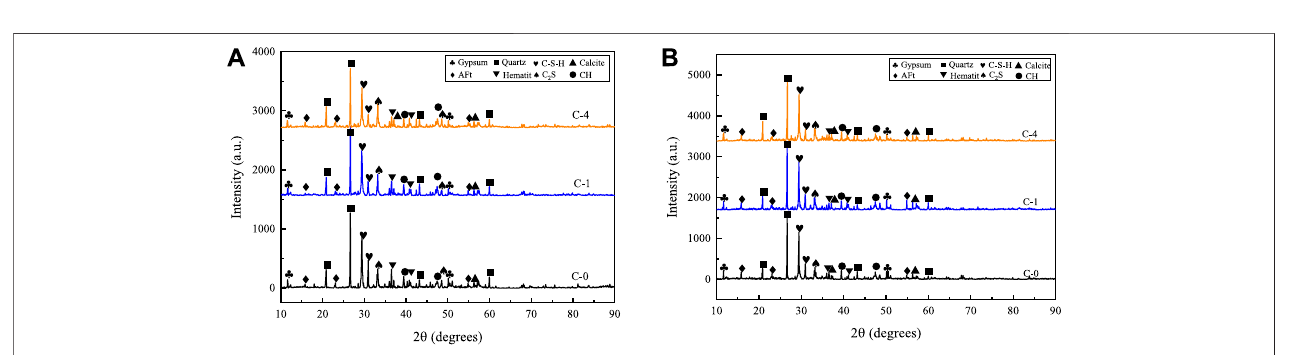
FIGURE 6 | X-ray diffraction (XRD) patterns of CTB and ARSCTB ( A -7 days; B -28 days).